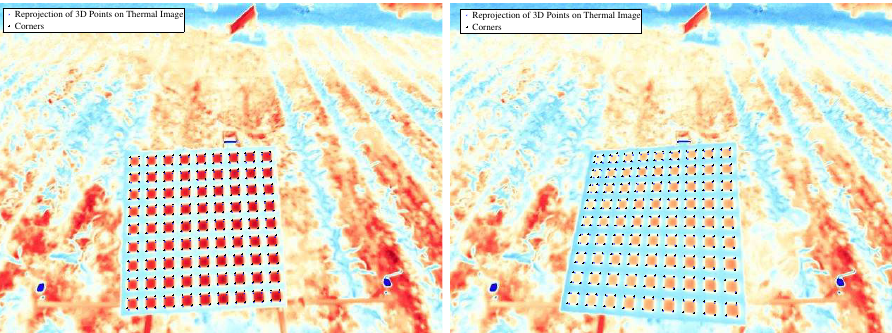
Figure 14. Re-projections of the 3D coordinates of the corners obtained from left-right stereo reconstruction onto the thermal images. The “x” indicate the re-projections, and “+” the extracted corners from the thermal image.